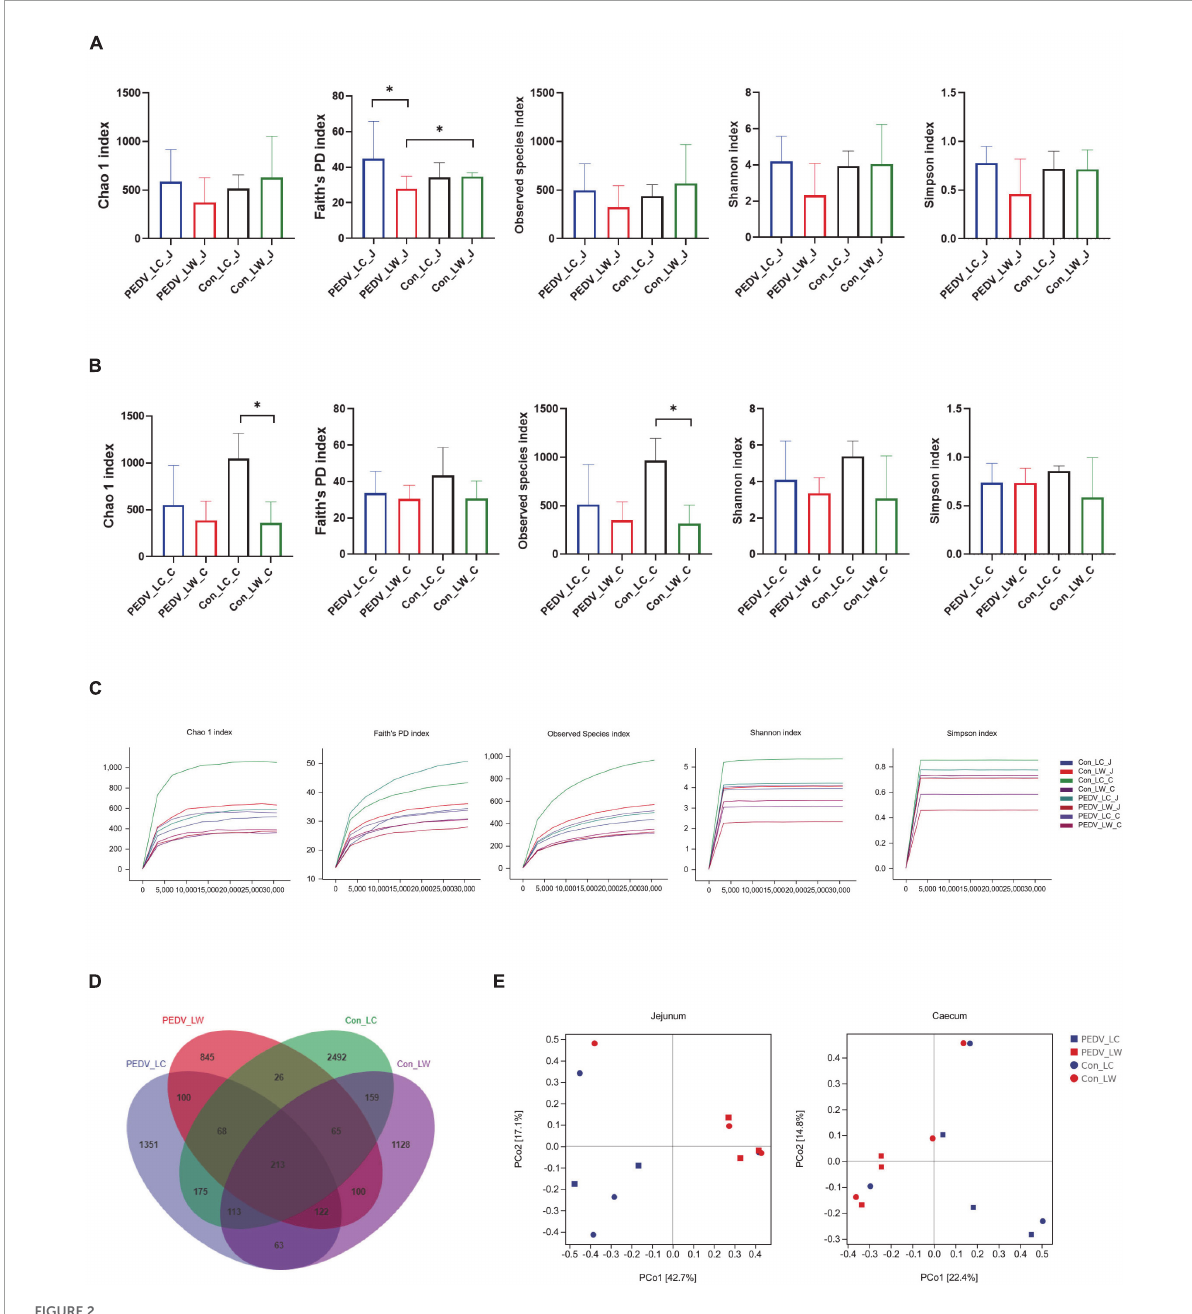
FIGURE2 (A) Microbial alpha diversity in the jejunum. (B) Microbial alpha diversity in the cecum. (C) Rarefaction curves of alpha diversity. (D) OTU venn diagram. (E) Principal coordinate analysis (PCoA) of intestinal microorganisms in piglets exposed to porcine epidemic diarrhea virus (PEDV)